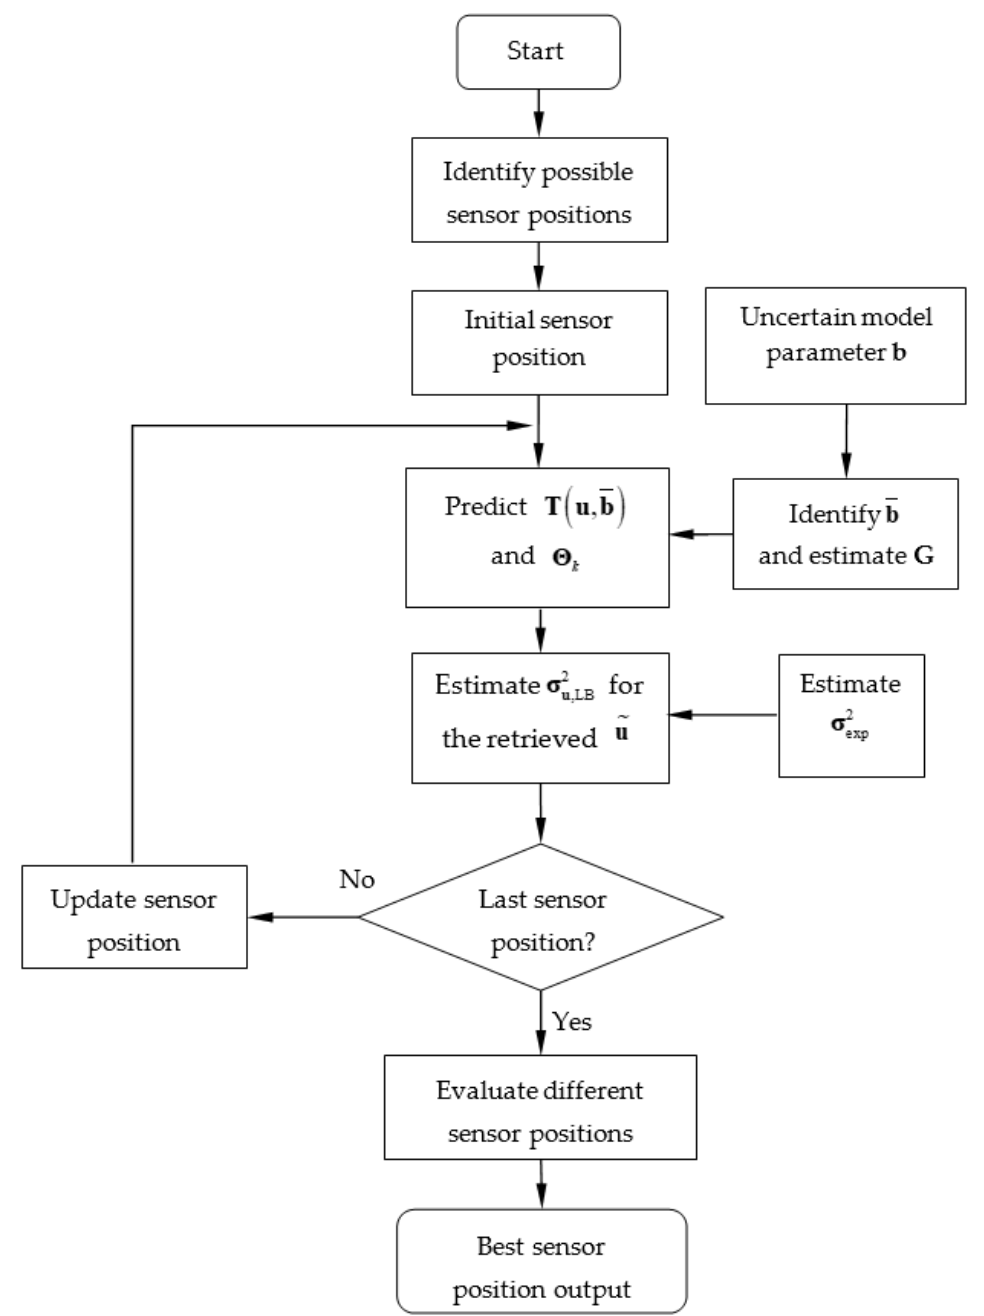
Figure 3. Flow chart of the optimal design of experiments based on the a priori estimation of the variance of the parameters to be retrieved.